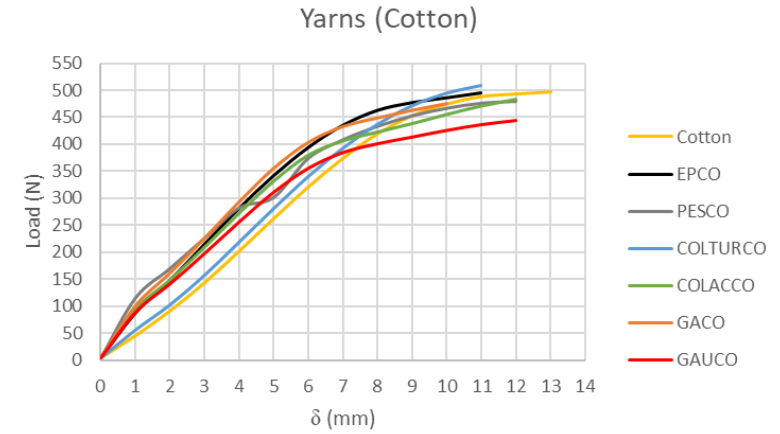
Figure 4. Load–extensometer curves for cotton Figure 4. Load – extensometer curves for cotton yarns.